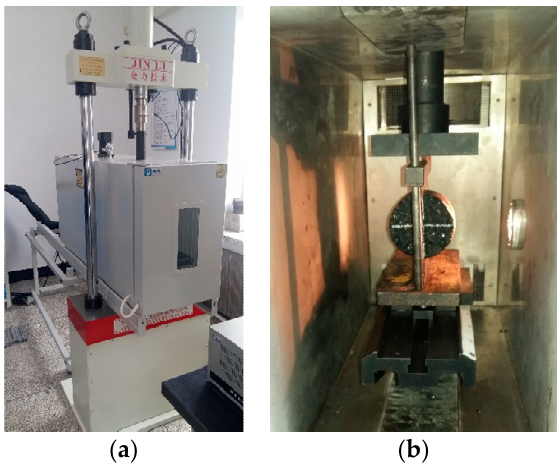
Figure 5. The low temperature indirect tensile test. ( a ) Testing equipment. ( b ) Testing progress.